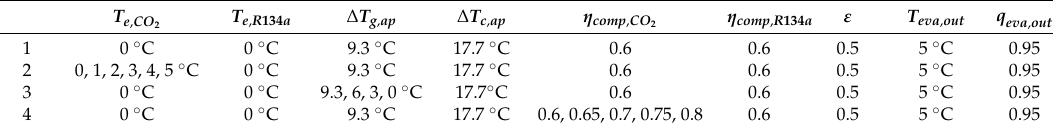
Table 3. Simulation conditions for system comparison between CO 2 and